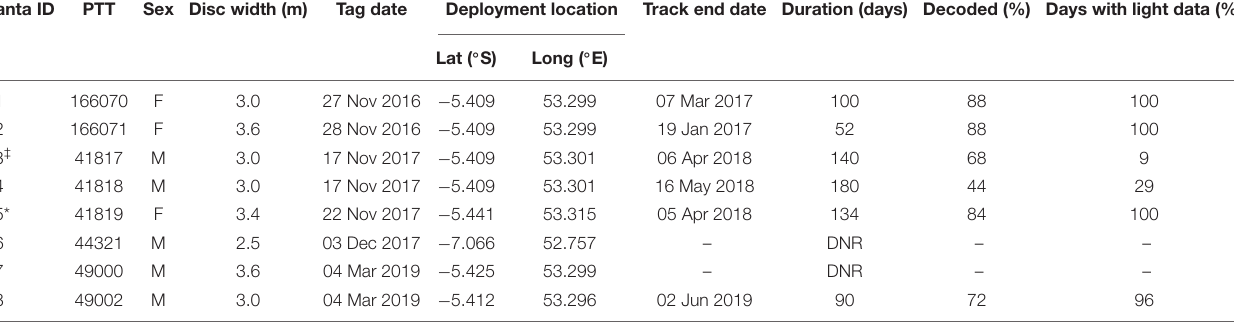
TABLE 1 | Summary of satellite tag deployments on reef manta rays ( Mobula alfredi ) in Seychelles including length of track (duration in days) and percentage of archived data decoded via satellite. Manta